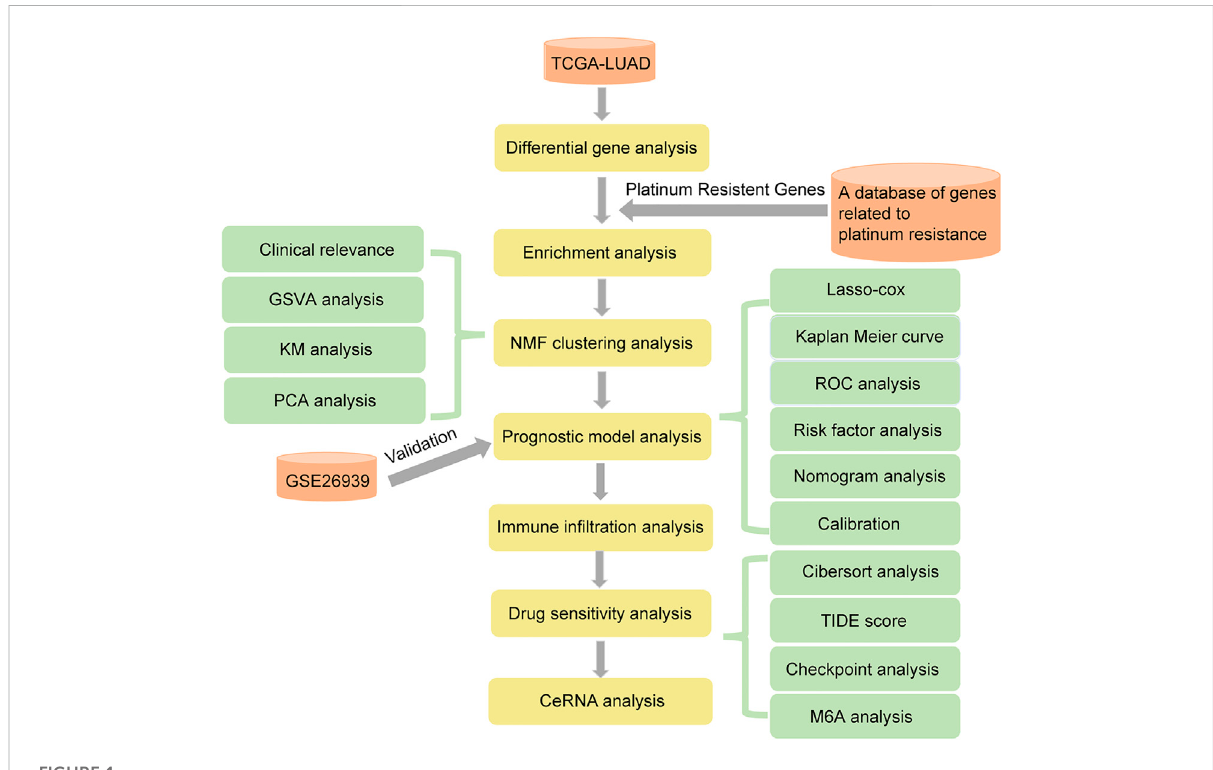
FIGURE 1 Work fl ow (Modify database